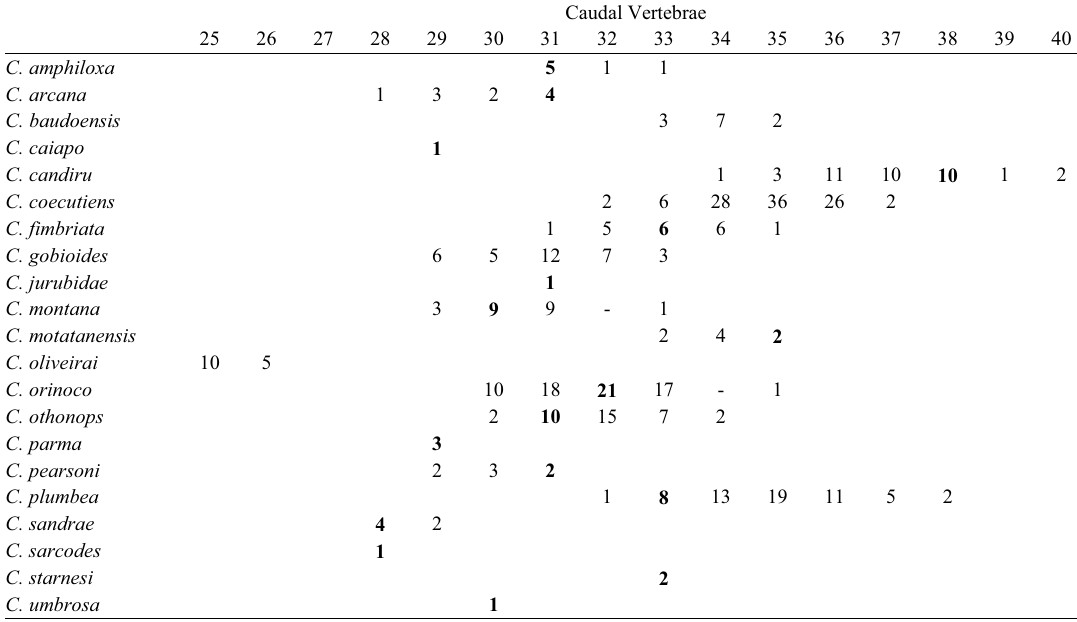
Table 14. Number of specimens of the species of Cetopsis with cited number of caudal vertebrae. Bold indicates value for holotype or lectotype when examined.